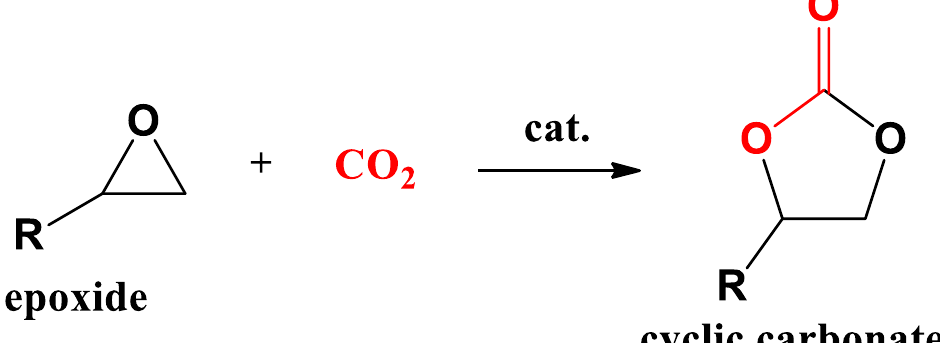
Figure 2. N 2 adsorption – desorption isotherms of MIL-100(Fe) synthesized. Table 1. Values of specific surface area, micropore volume, and mesopore volume for the synthe- sized MIL-100(Fe), determined from N 2 sorption measurements. Samples